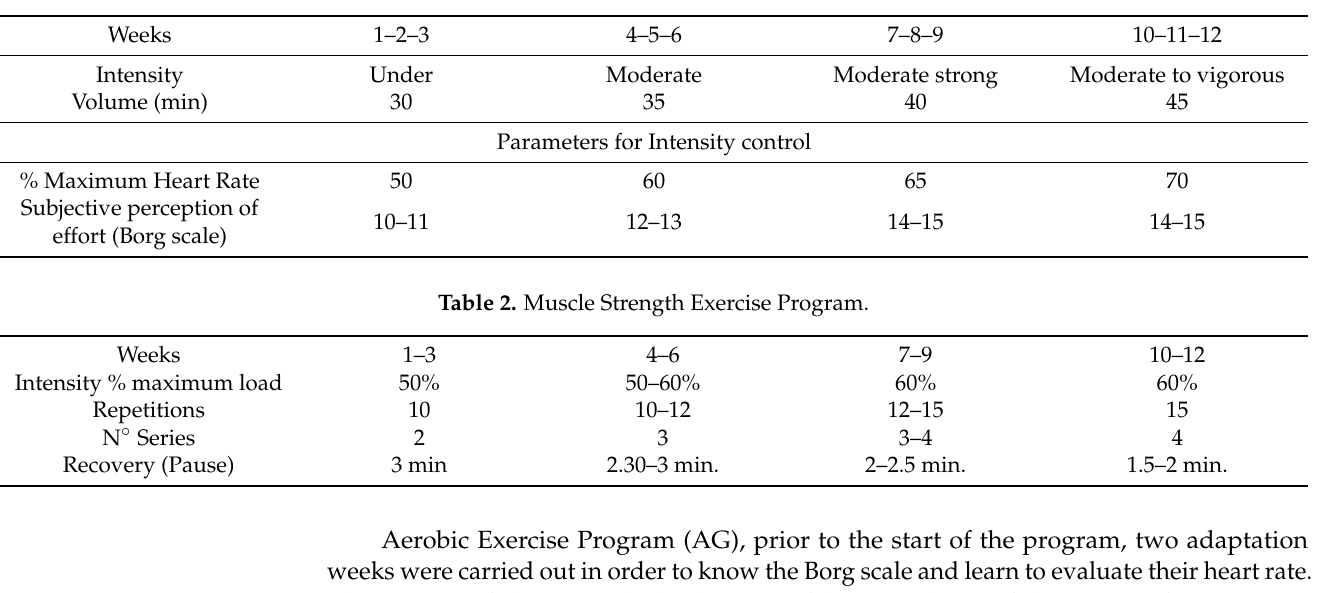
Table 1. Aerobic Exercise Program.